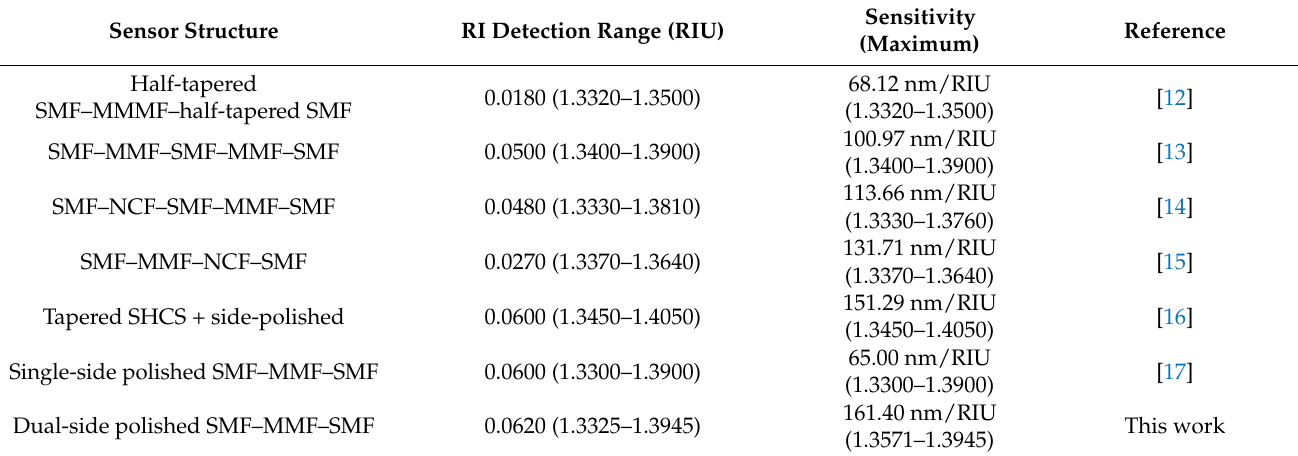
Table 1. Comparison of fiber-optic RI sensors based on SMS fiber structure. Sensor